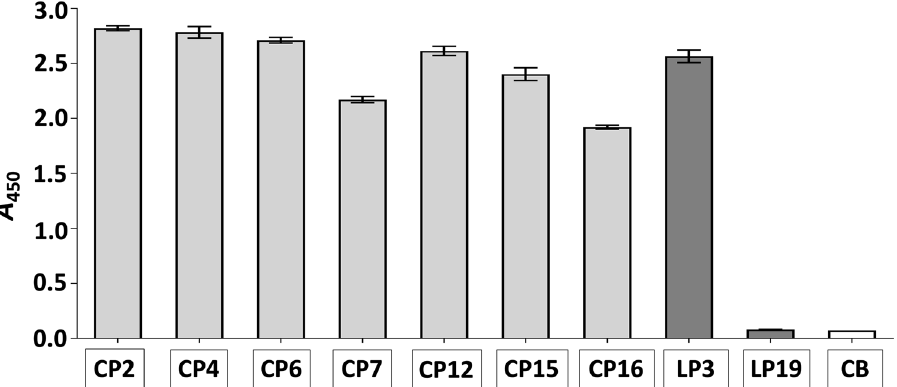
Figure 3. Assessment of the interaction between peptides and rDIII. Framed reagents were coated into microtiter wells (Nunc CovaLink NH plates), incubated with rDIII, and the interaction was detected with HisProbe-HRP conjugate. Data present mean of triplicates with ± S.D after subtraction of negative control (rDIII was excluded from the assay). CB – coating buffer (1-ethyl-3-(3-dimethylamino-propyl)-carbodiimide, EDC plus sulfo-N-hydroxysuccinimide, sulfo-NHS); CP – cyclic peptide; LP – linear peptide. Please note that, all wells were blocked with a blocking buffer (0.5% BSA in PBS) after overnight coating.